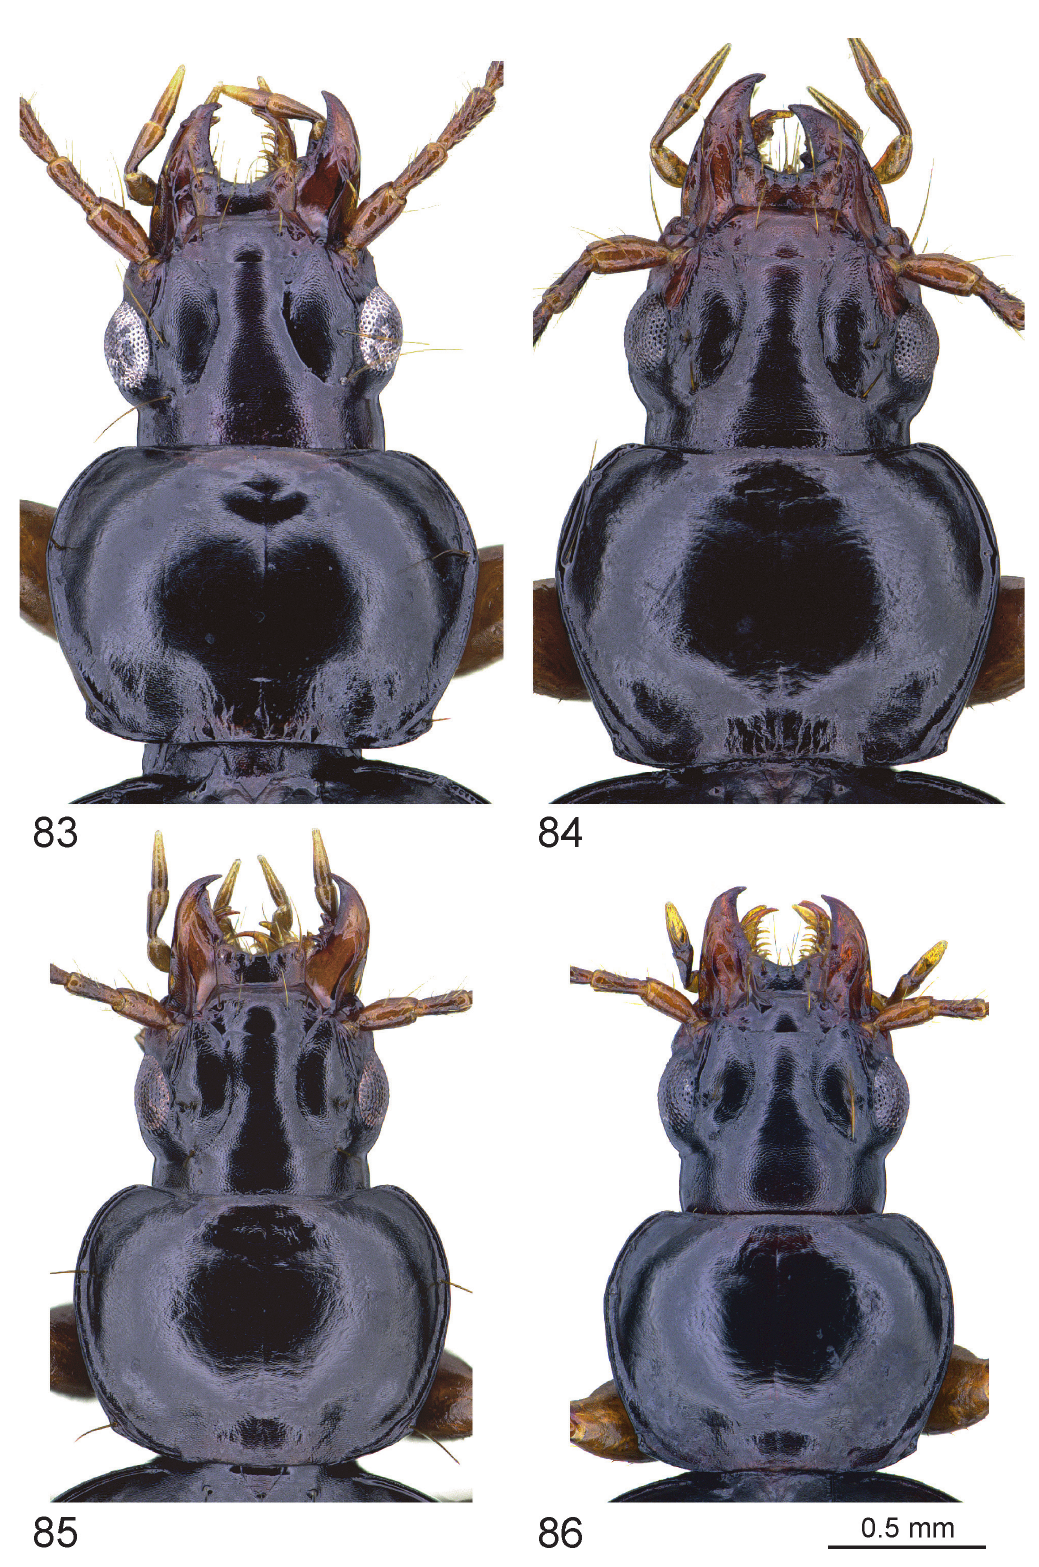
Figs 83–86. Trechus spp., head, pronotum. 83 . T. wiersbowskyi sp. nov., paratype, ♂. 84 . T. grandipennis sp. nov., holotype. 85 . T. sanettii sp. nov., paratype, ♂. 86 . T. abalkhasimi sp. nov., paratype,